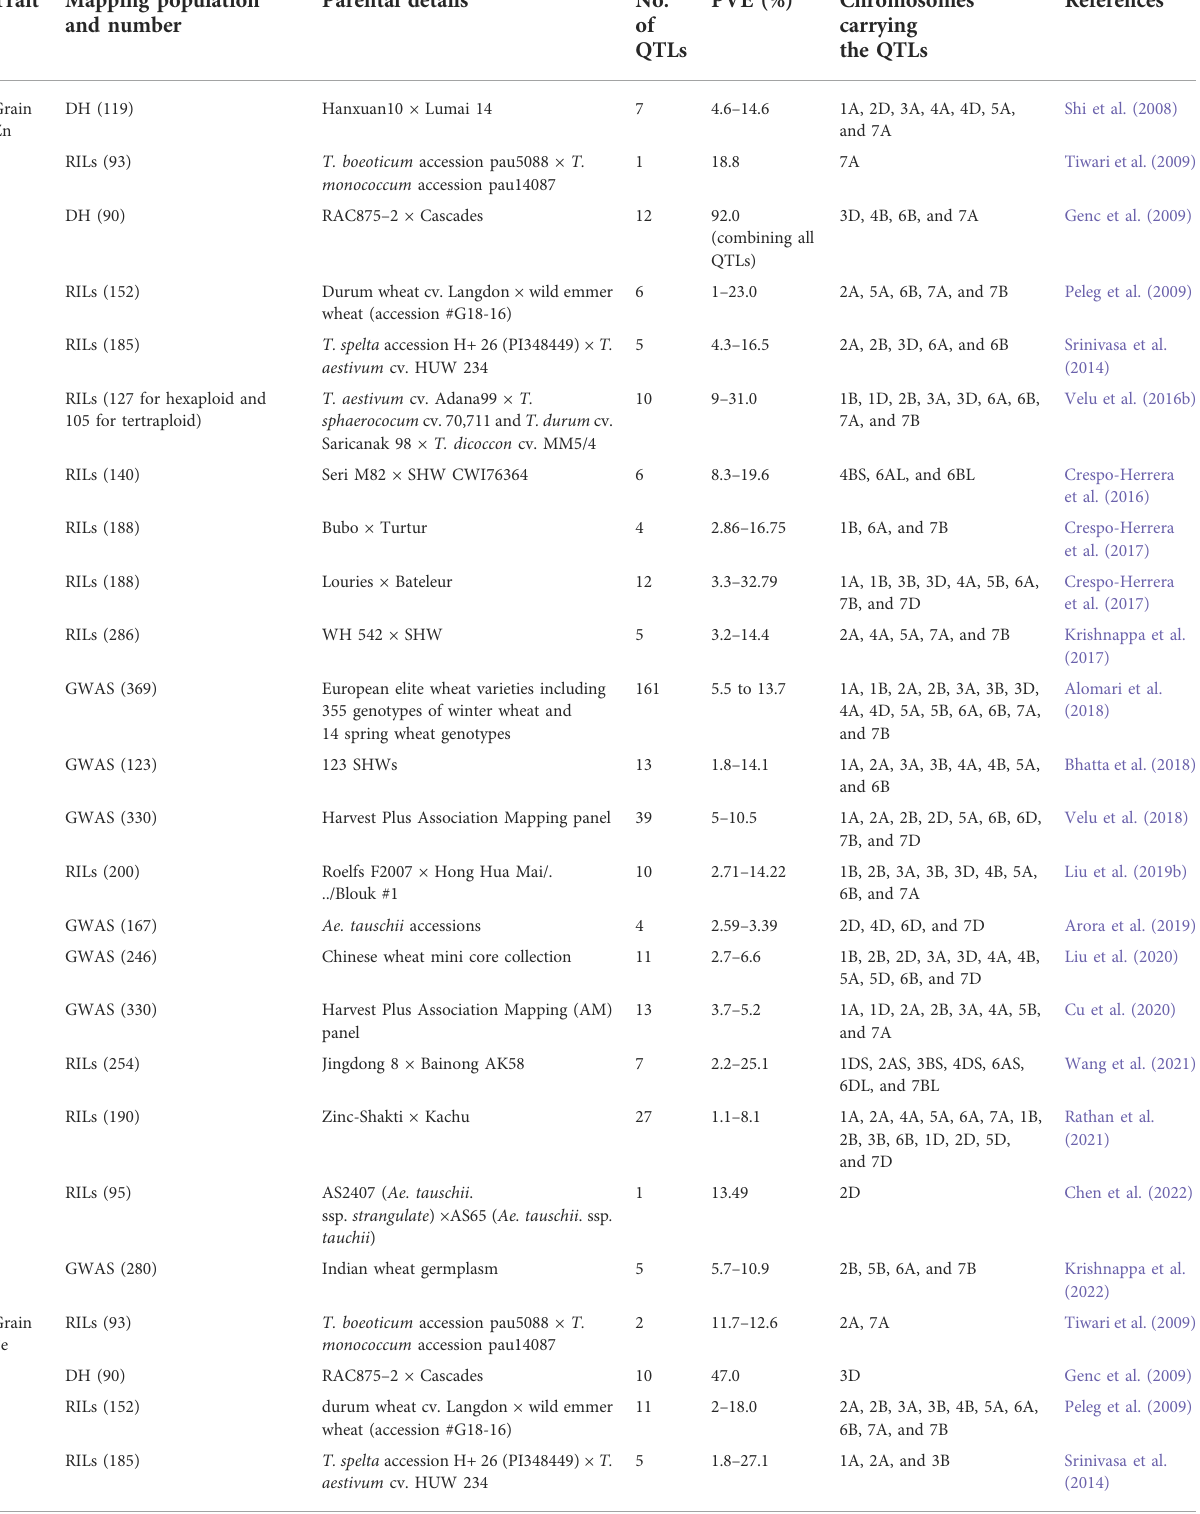
TABLE2Mappingpopulation,numberofQTLsdetectedalongwiththeirpercentofphenotypicvariationexplained(PVE%)andchromosomecarrying the QTLs for grain zinc and iron in